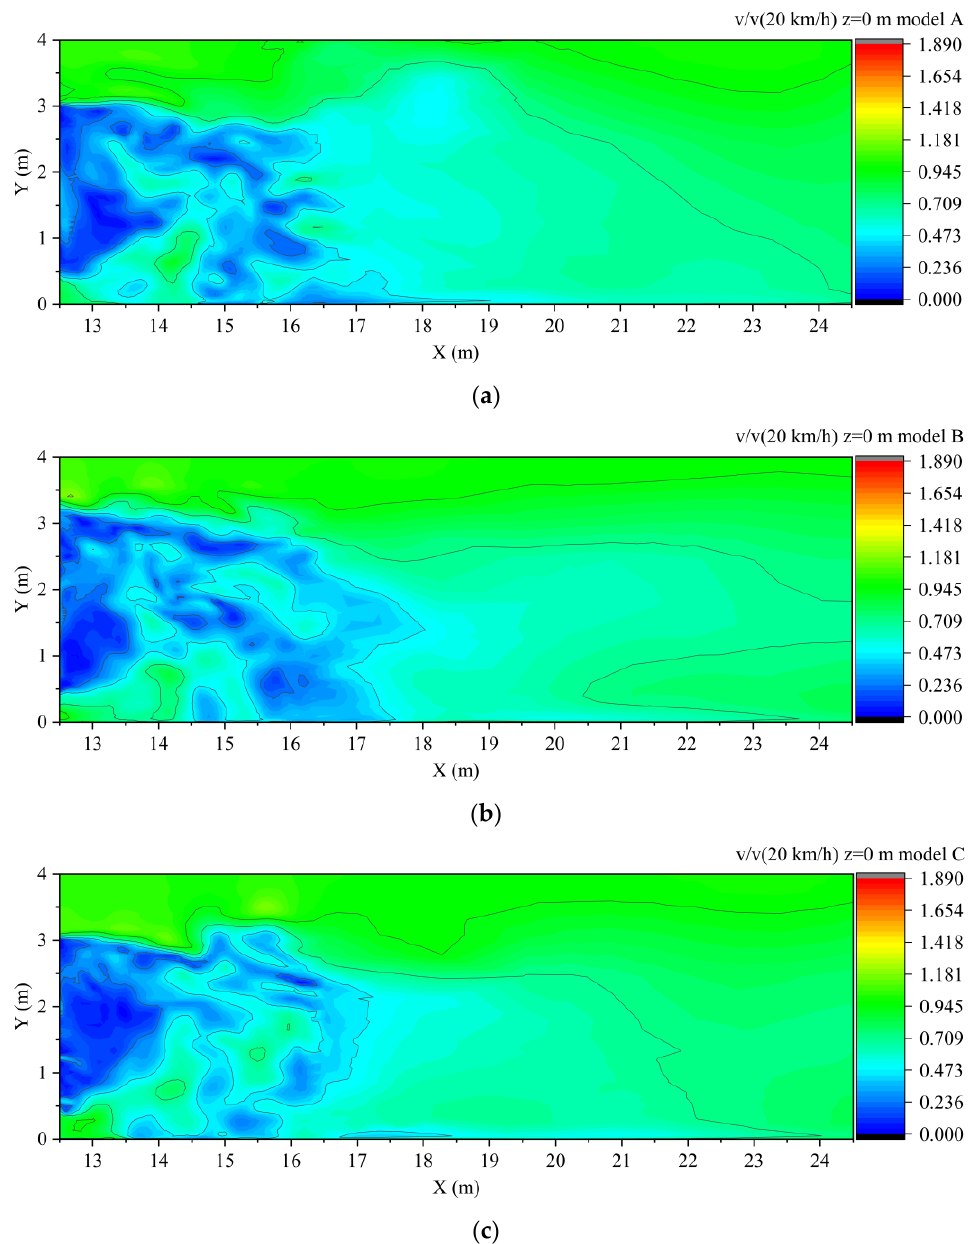
Figure 5. Longitudinal midsection velocity distribution for the rear wake region for ( a ) model A; ( b ) model B; ( c ) model C.